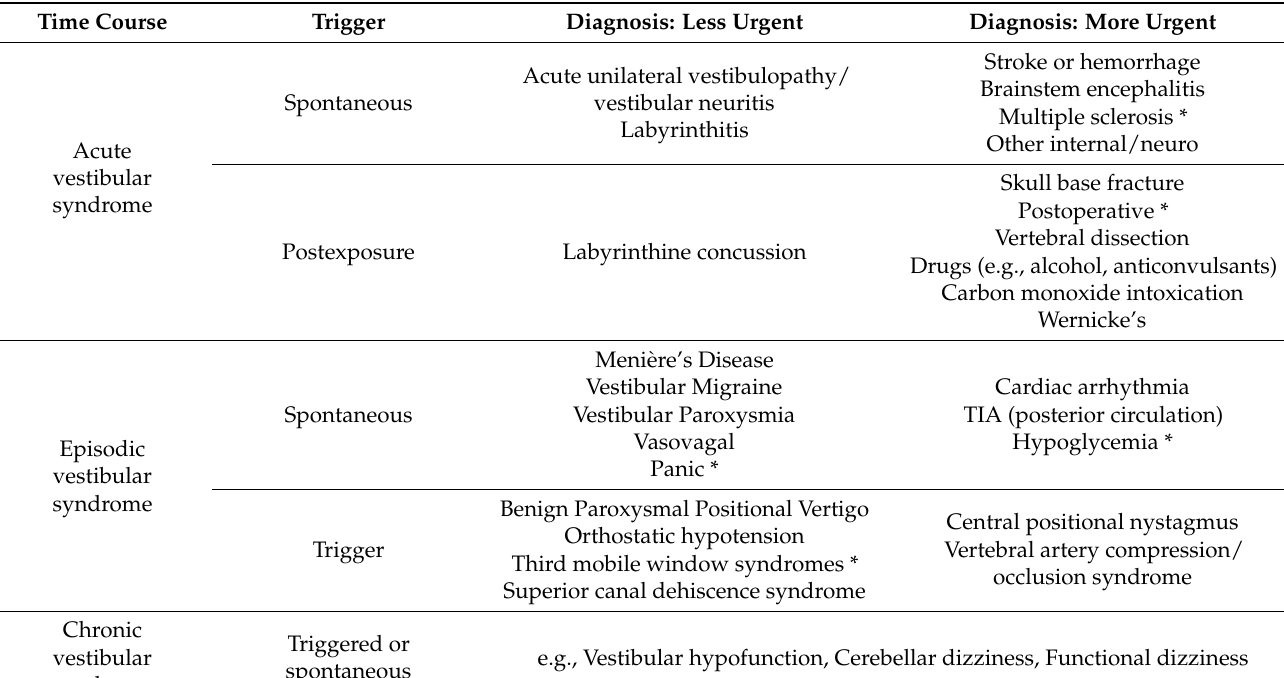
Table 1. Vestibular syndromes categorized by time course and triggers. Modified and updated from